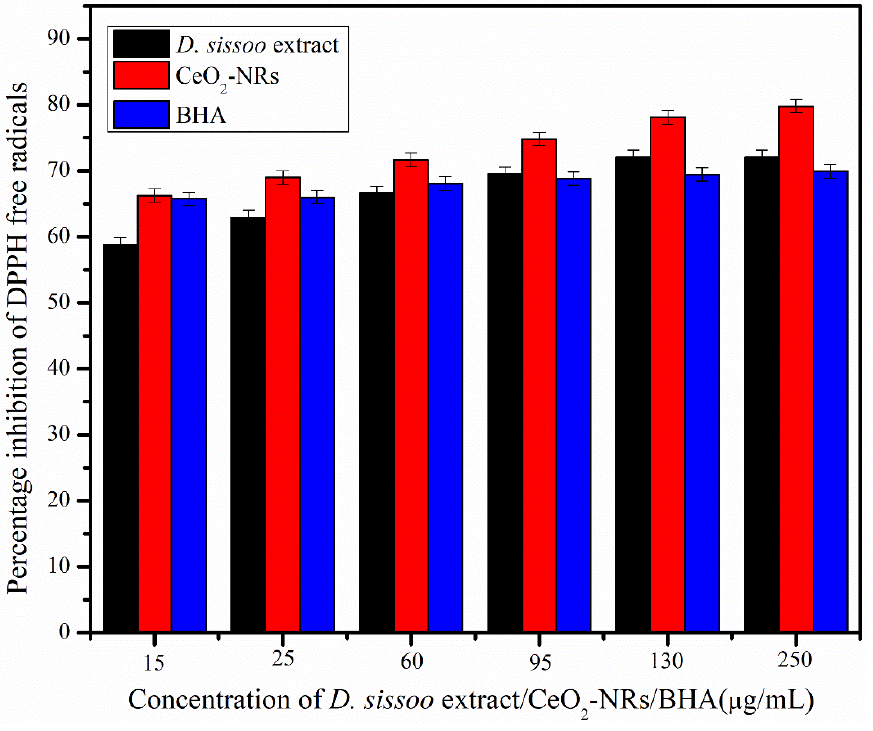
Figure 6. The DPPH assay for D. sissoo , CeO 2 -NRs, and BHA.